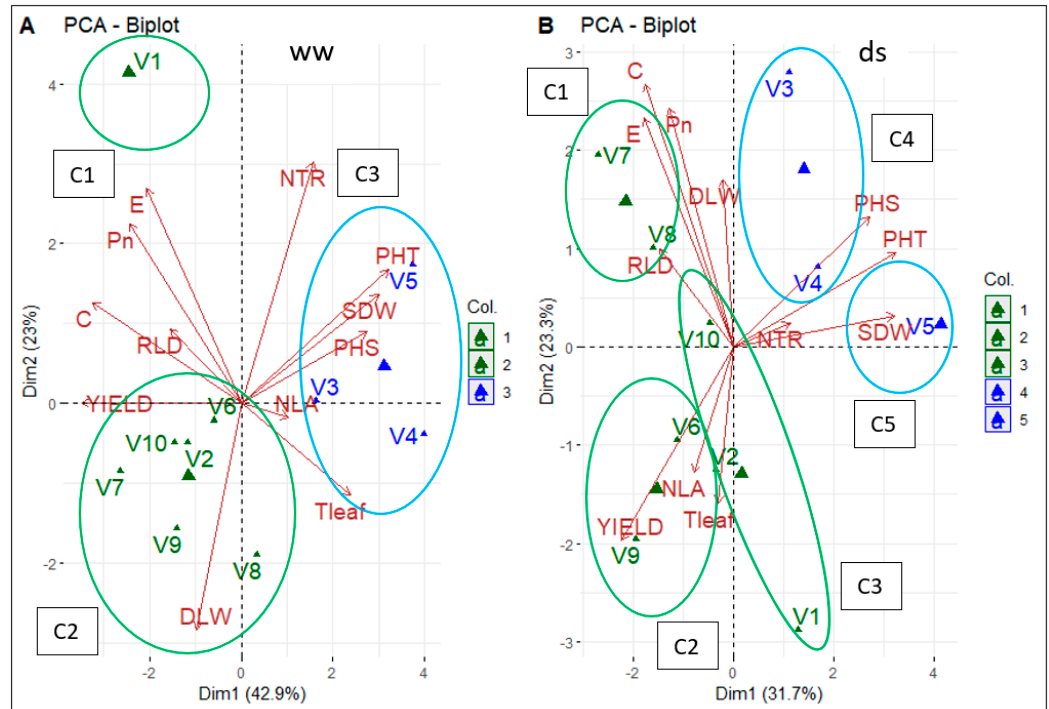
Figure 5. Principal component analysis biplot of agro morphological and physiological traits of 10 sorghum varieties (V) under well-watered ( A ) and drought stress conditions ( B ). The C inside the rectangle followed by a number represents the cluster number; ww: well-watered environment; ds: drought stress environment; NLA: number of leaf appeared; PHS: plants height after stress; DLW: dead leaves weight; PHT: plants height at harvest; SDW: Straw dry weight; Yield: grain yield (kg ha − 1 ); Pn: photosynthesis rate; C: stomatal conductance; E: leaf transpiration; Tleaf: leaf temperature; NTR: number of total roots; RLD: root length density; col: stand for the colors of the different clusters.